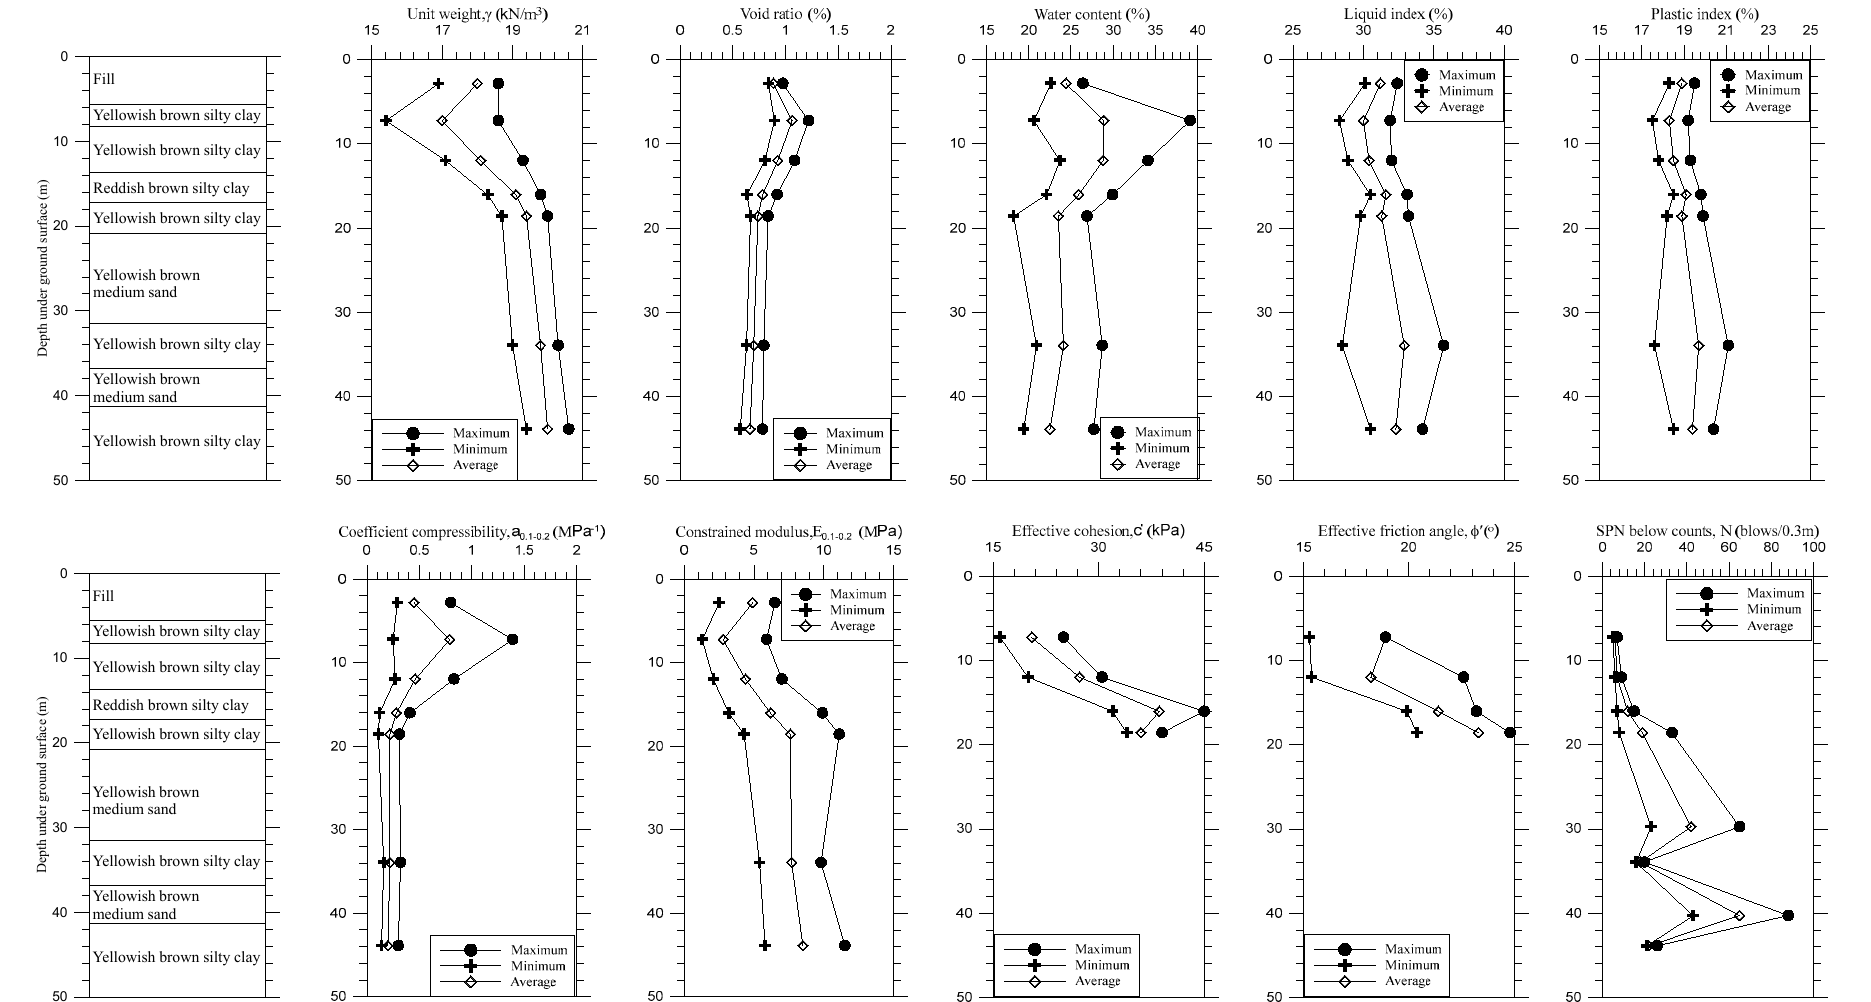
Figure 1. Soil profiles and material properties.